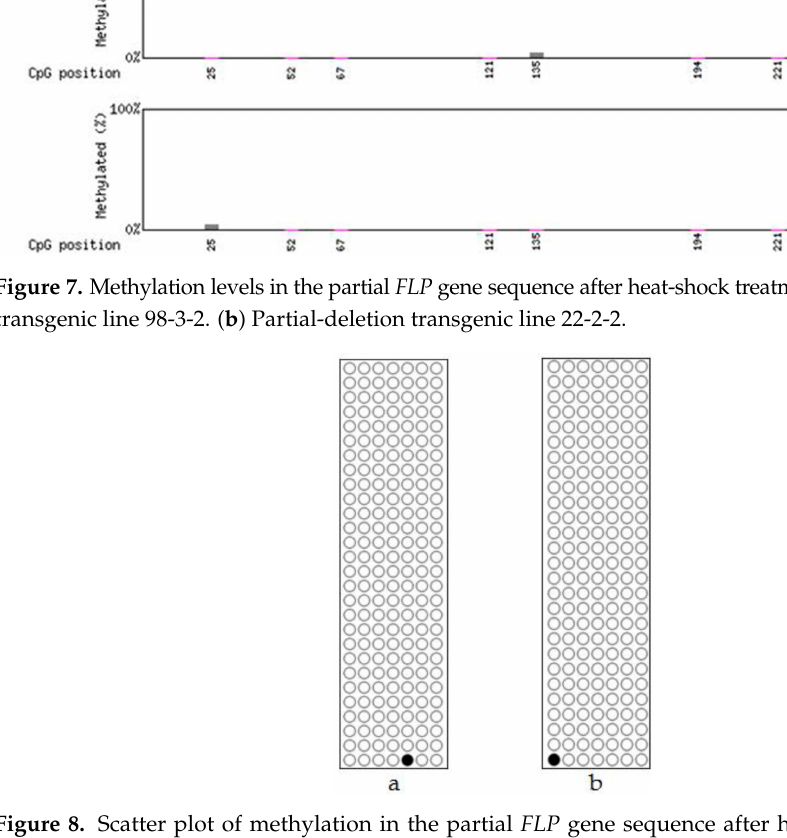
Figure 8. Scatter plot of methylation in the partial FLP gene sequence after heat-shock treatment. ( a ) Non-deletion transgenic line 98-3-2. ( b ) Partial-deletion transgenic line